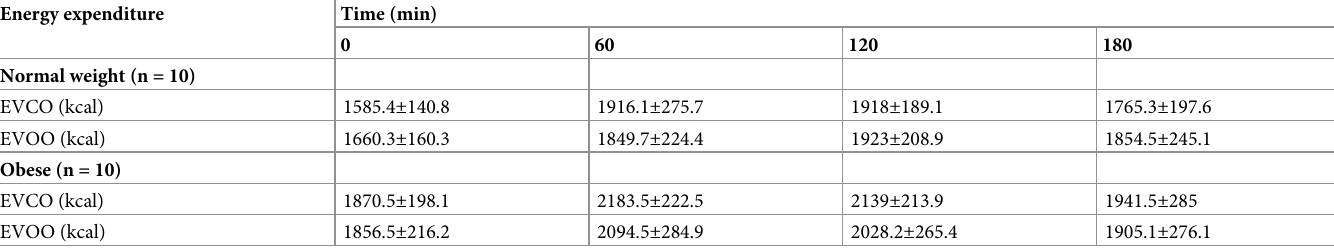
Data was presented as mean ± standard